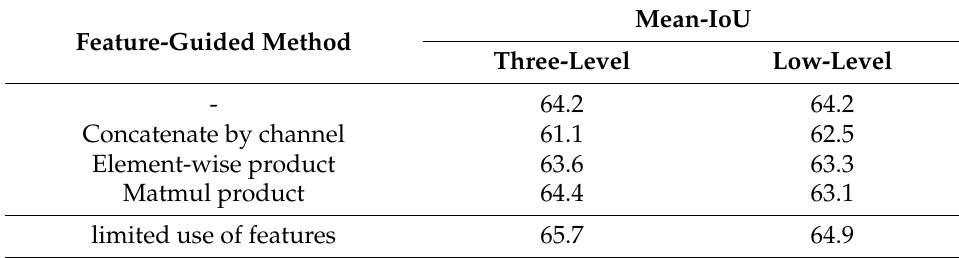
Table 5. Experimental results of ablation with different feature-guided methods on the